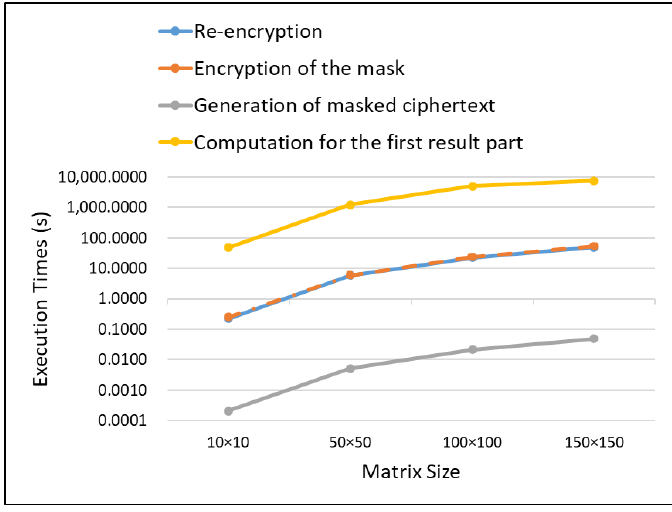
Figure 4. The time cost for CSP 1 .